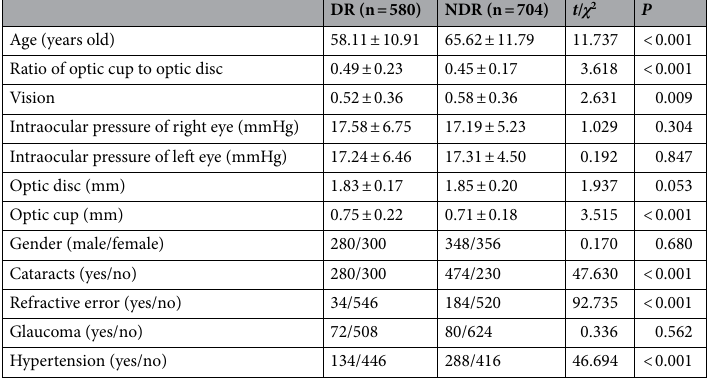
Table 1. General characteristics of the DM